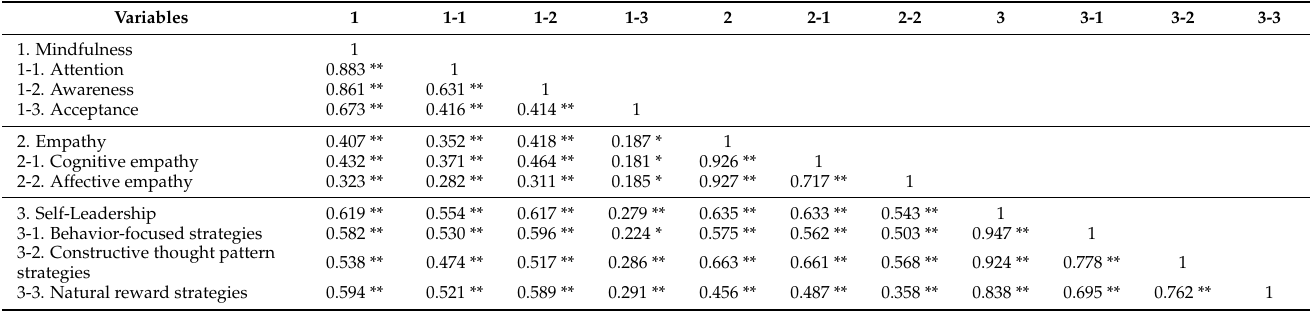
Table 2. Correlations between the study variables.